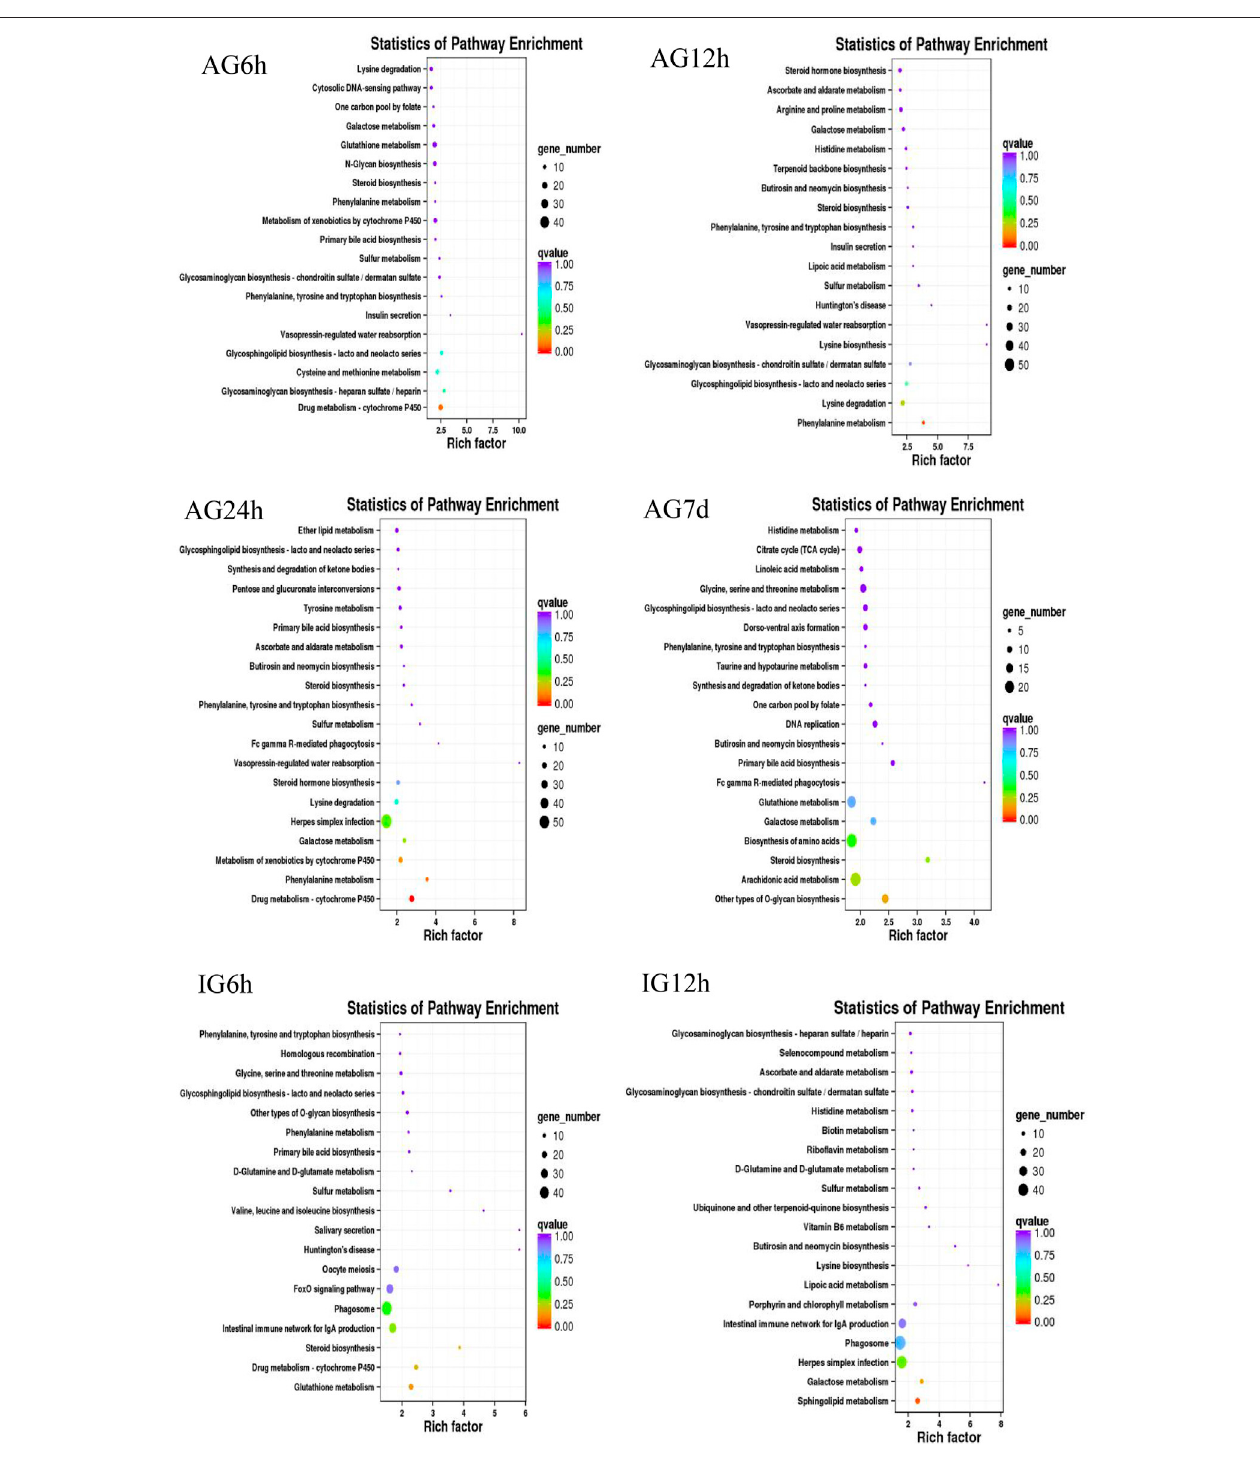
FIGURE 3 | Nile tilapia DEGs in KEGG classi fi cation after Streptococcus infection.